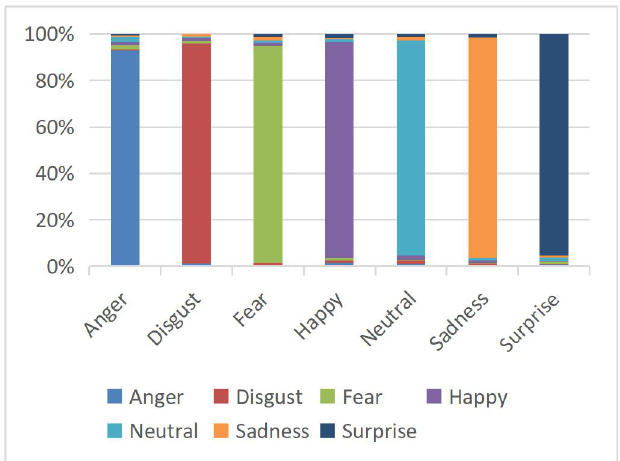
Figure 7. The corresponding bar chart in Table 3